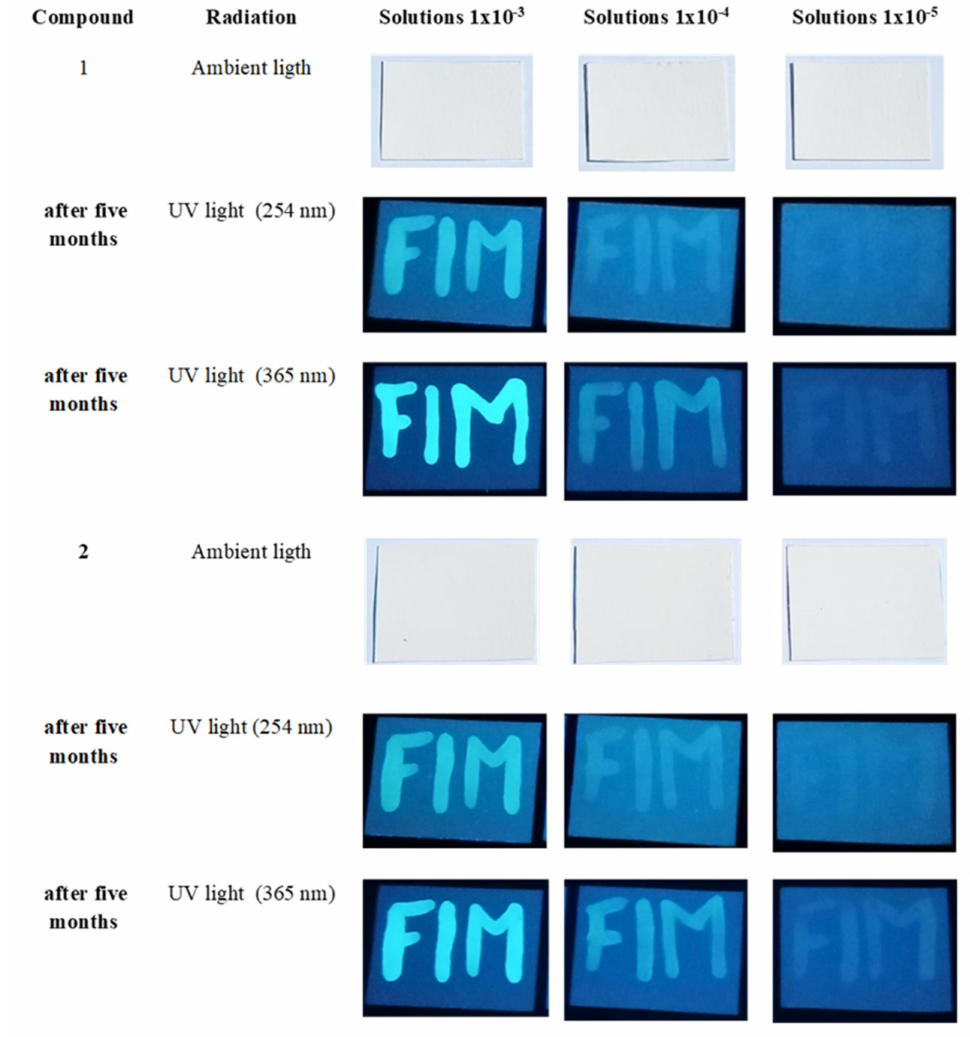
Figure 15. Results of security-ink tests using solutions of complexes 1 and 2 in ethanol with concentrations of 1.0 × 10 − 3 , 1.0 × 10 − 4 , and 1.0 × 10 − 5 M, under ambient light and UV light (365 and 254